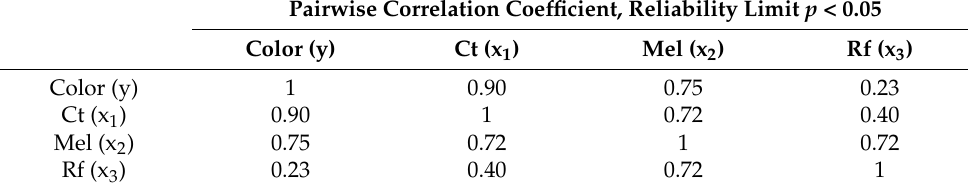
Table 6. Pairwise correlation coefficients between organic components. Pairwise Correlation Coefficient, Reliability Limit p < 0.05